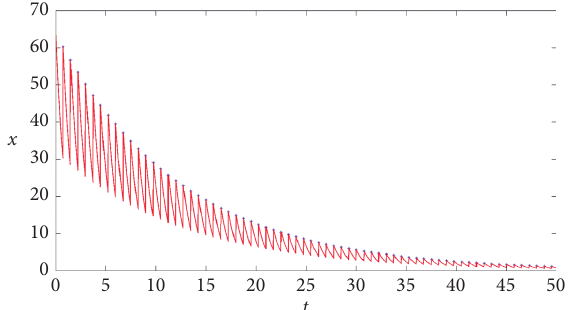
Figure 1: The trajectory of the state of system (25) corresponding to the initial condition x ( 0 ) � 64 and the resetting time t � 0 . 75 k, k � 1 , 2 , ... , . k